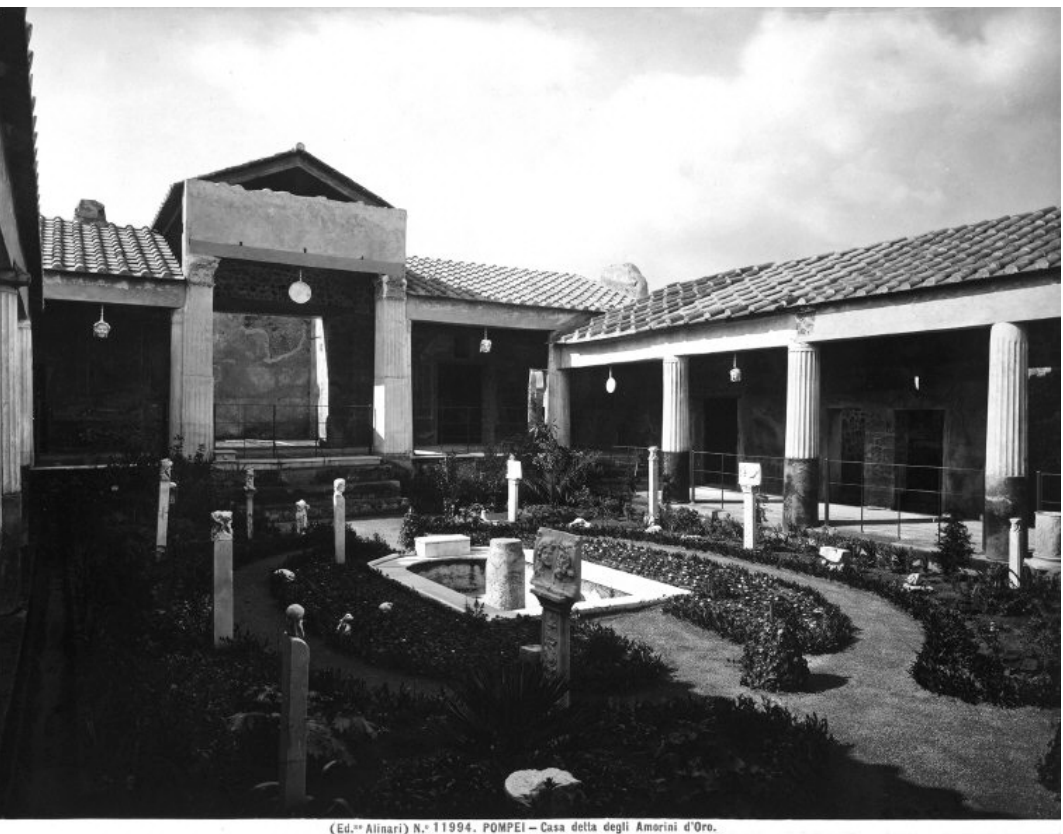
Figure 2. Oscilla hanging in the liminal space between peristyle and garden. House of the Gilded Cupids, Pompeii, ca. 1900. Photograph. Alinari/Art Resource, NY. Used by Permission.